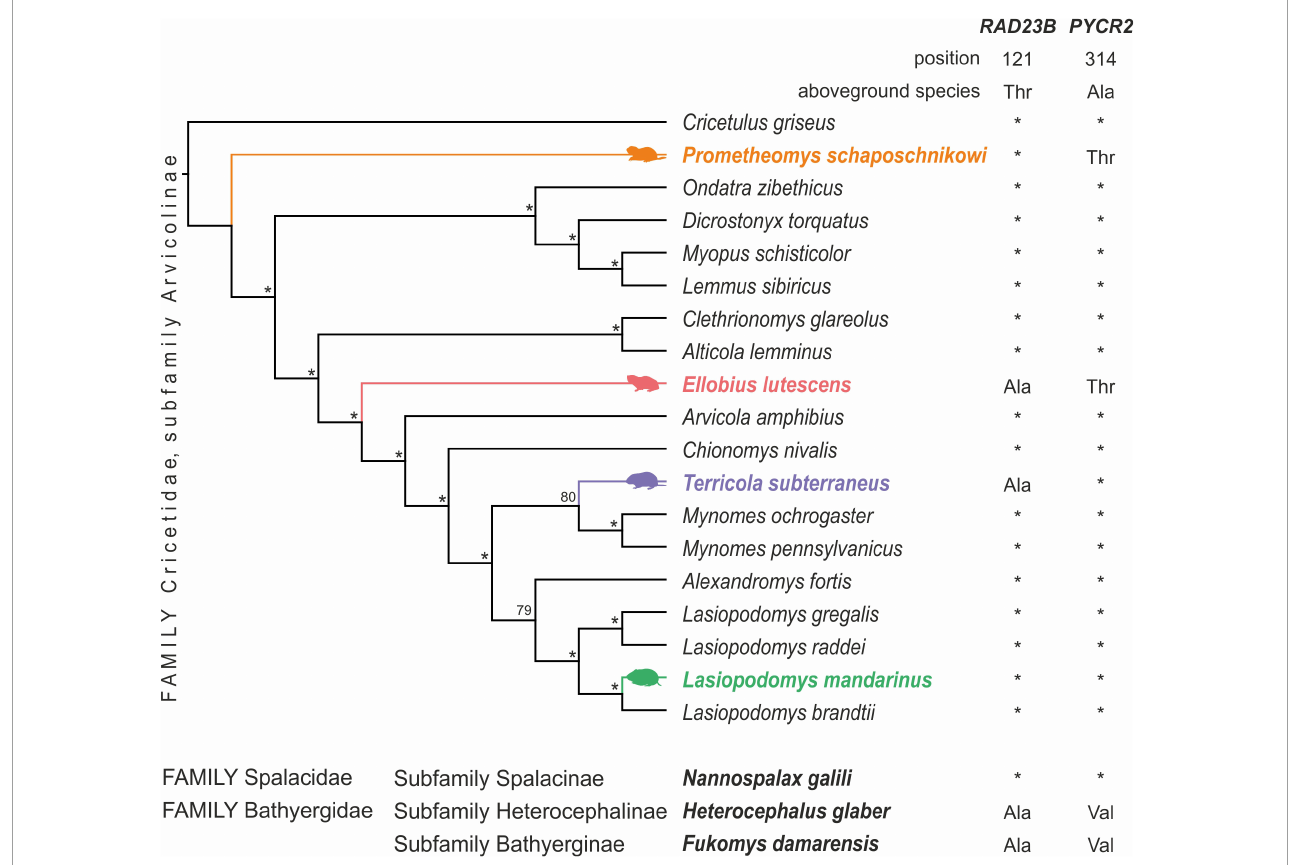
FIGURE1 Phylogenetic tree of Arvicolinae subfamily based on transcriptome data with observed substitutions unique for subterranean species. Subterranean Arvicolinae species are shown in color. Nodes with 98–100 ML support are marked with an asterisk. On the right, the amino acid substitutions in certain positions are shown. Below the tree, the amino acid substitutions in the same sites in specialized subterranean rodents from other families are shown.